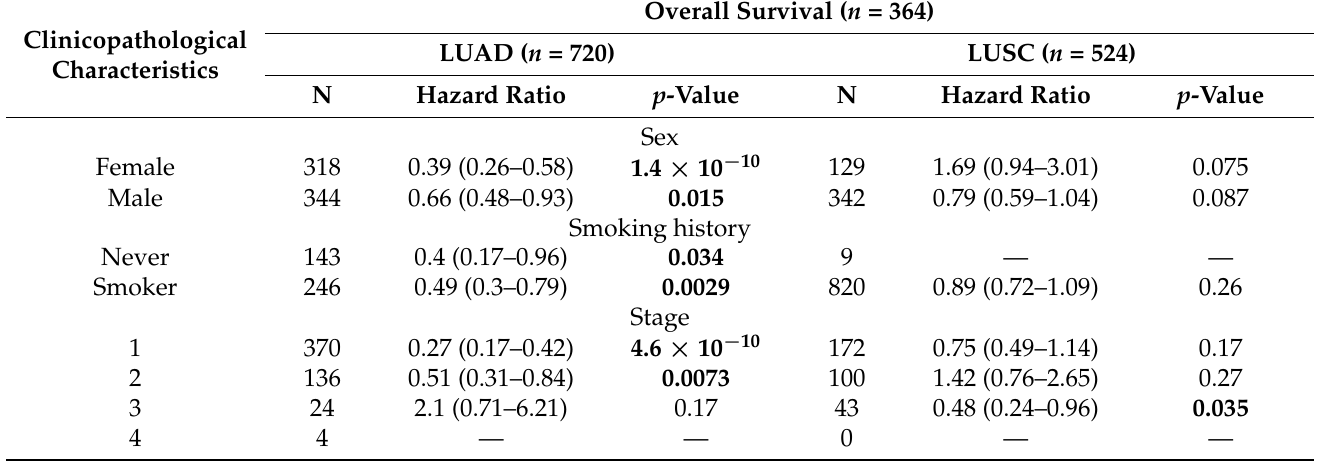
Table 1. Correlation of the mRNA expression level of LPAR6 in different stage and clinical prognostic potential in lung Cancer with different clinicopathological factors.